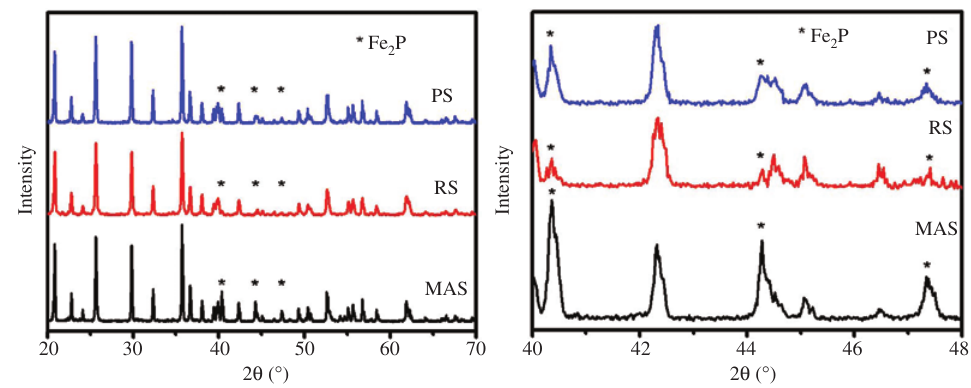
Figure 1: The XRD patterns of samples (left) and the local zoom